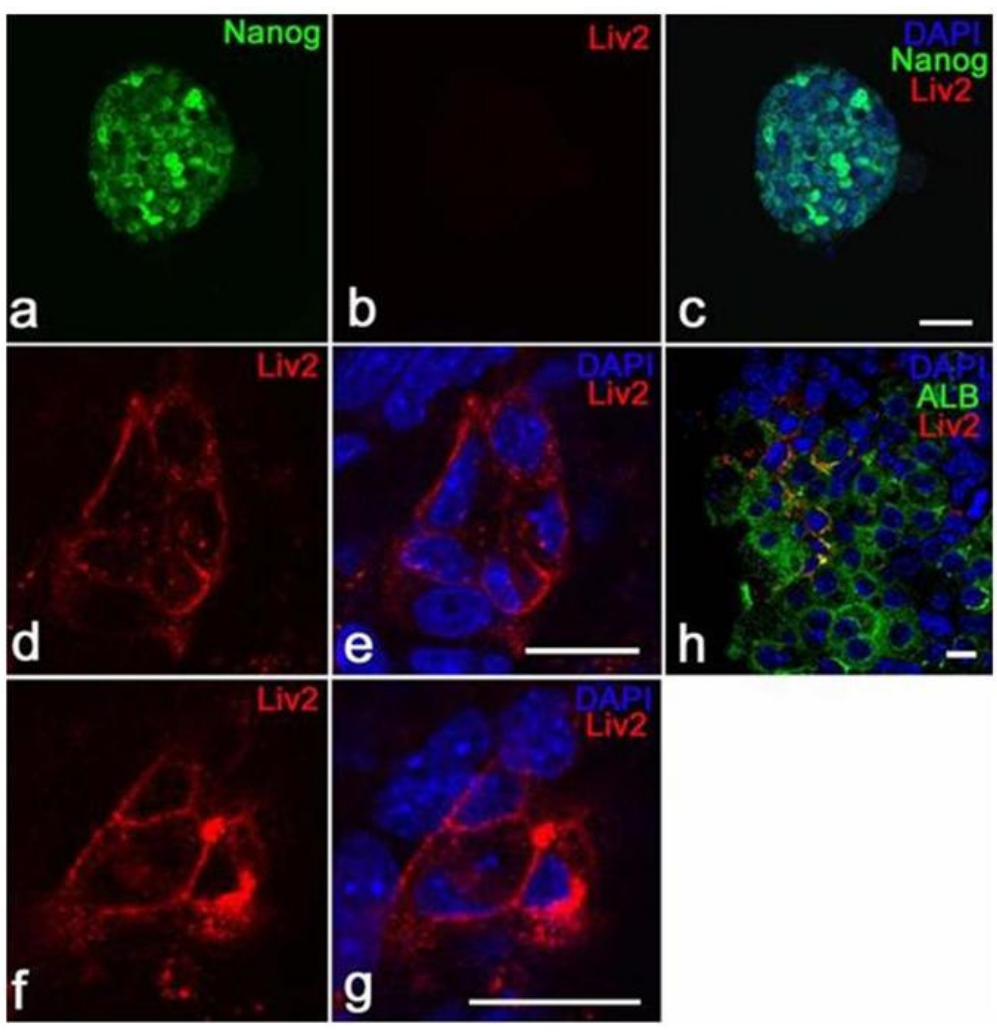
FIGURE 5 . Liv2 immunoreactivity in ES cells (a–c) and EB outgrowth (d-h). (a–c) Liv2 (red) immunoreactivity was not seen in ES cells, which were positive for the marker of undifferentiated cells, Nanog (green). (d–g) EBs on day 7 showed Liv2-positive clusters consisting of a few cells with the same pattern of immunoreactivity as seen in fetal hepatocytes. (h) In EB outgrowth on day 18, Liv2-positive cells were merged with ALB, which is a marker of hepatocytes. Bars = 20 µ m.